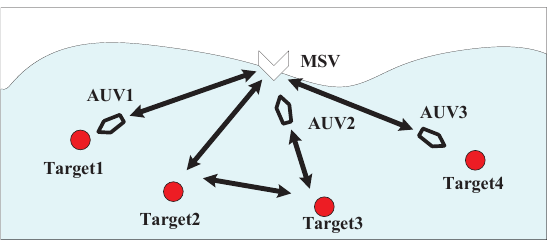
Figure 1. 2D exemplification of a multi-AUV target information collection mission by L&R from an MSV.